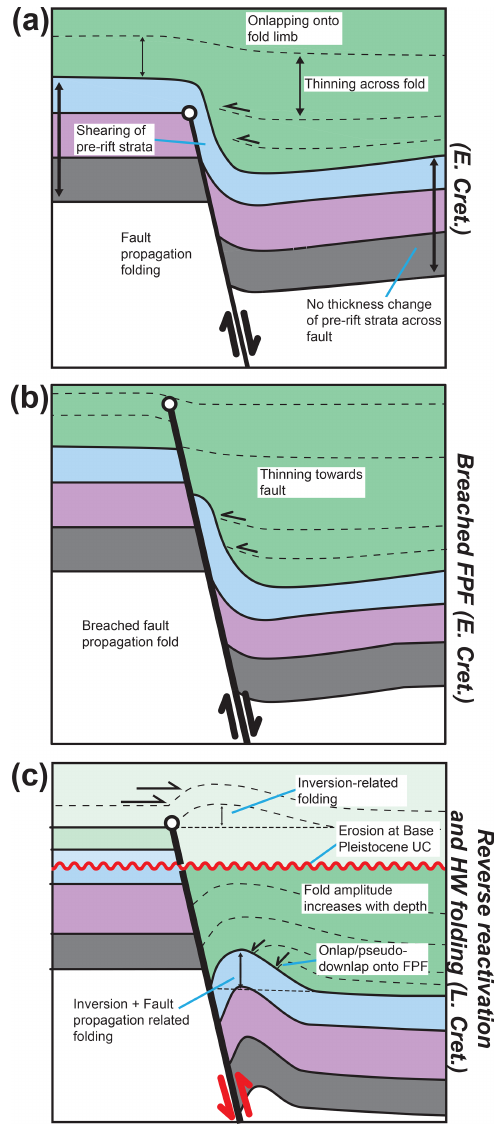
Figure 11. Schematic model illustrating the inversion of a pre- existing fault propagation fold. (a) An initial stage of fault prop- agation folding occurred during Early Cretaceous slip along the fault. Lower Cretaceous strata onlap onto the basinward-facing limb of the fold. (b) Following further slip along the fault, the fault propagation fold becomes breached. (c) Reverse reactivation of the fault and folding of hangingwall strata occur during the Late Cre- taceous. At shallow depths, this creates an inversion-related mono- cline, whereas at greater depths, the pre-existing monocline is tight- ened, forming a composite Early Cretaceous fault propagation and Late Cretaceous inversion-related